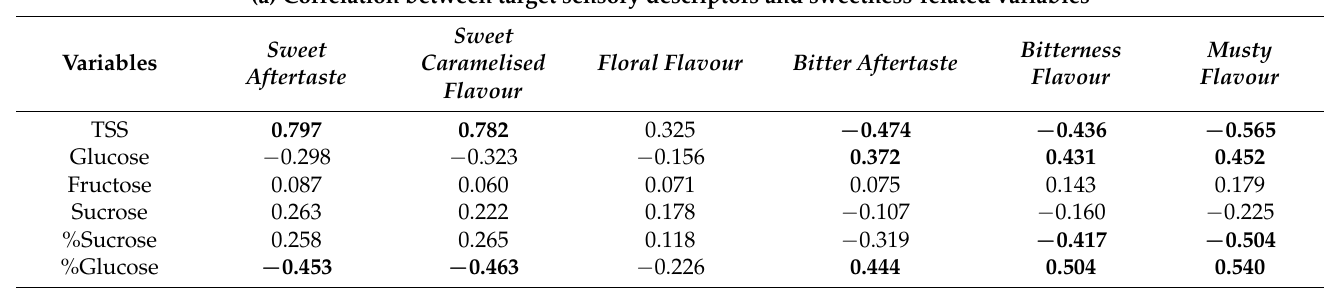
Table 4. Correlation between target sensory descriptors and biochemical